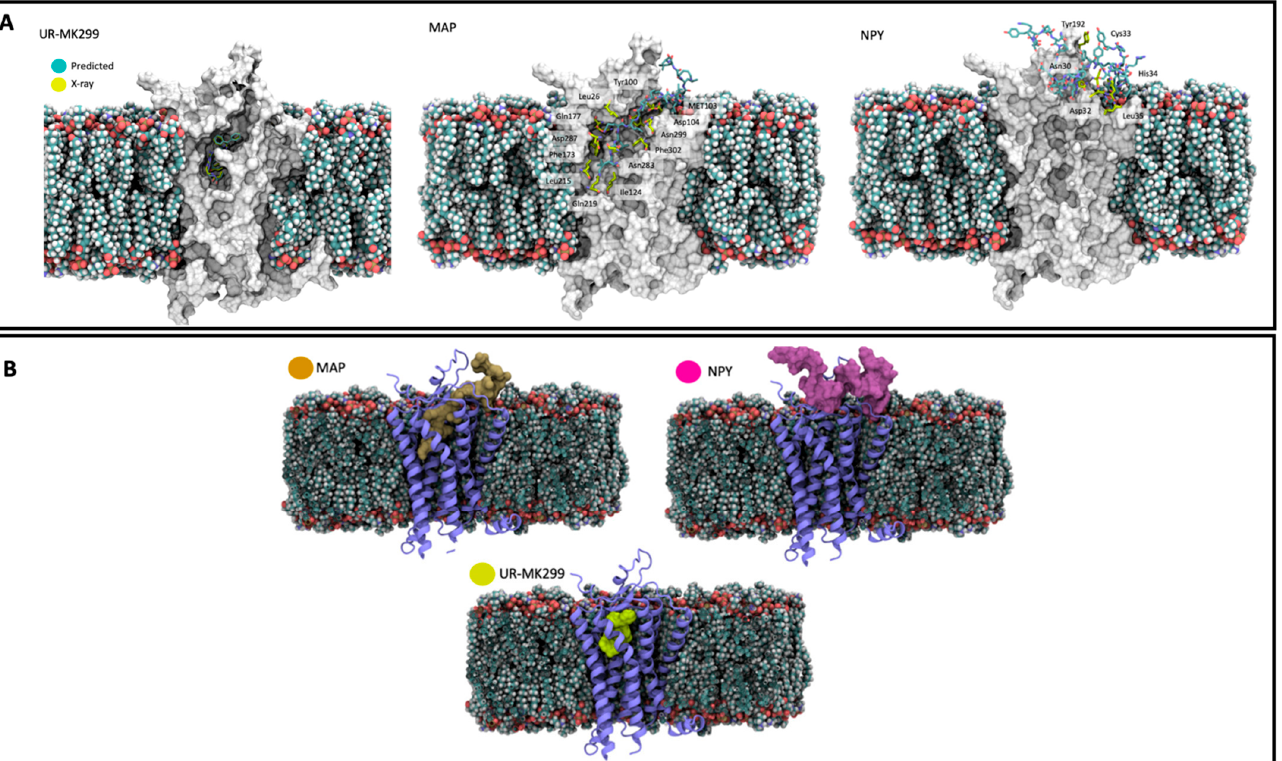
Figure 3. ( A )—Slab-view interaction with UR-MK299, MAP and NPY against NPY1R obtained by molecular docking with information obtained by X-ray diffraction. ( B )—Representation of the volume occupied by UR-MK299, MAP and NPY when complexed with NPYR1 (Reproduced and edited from [71], MDPI, 2022).